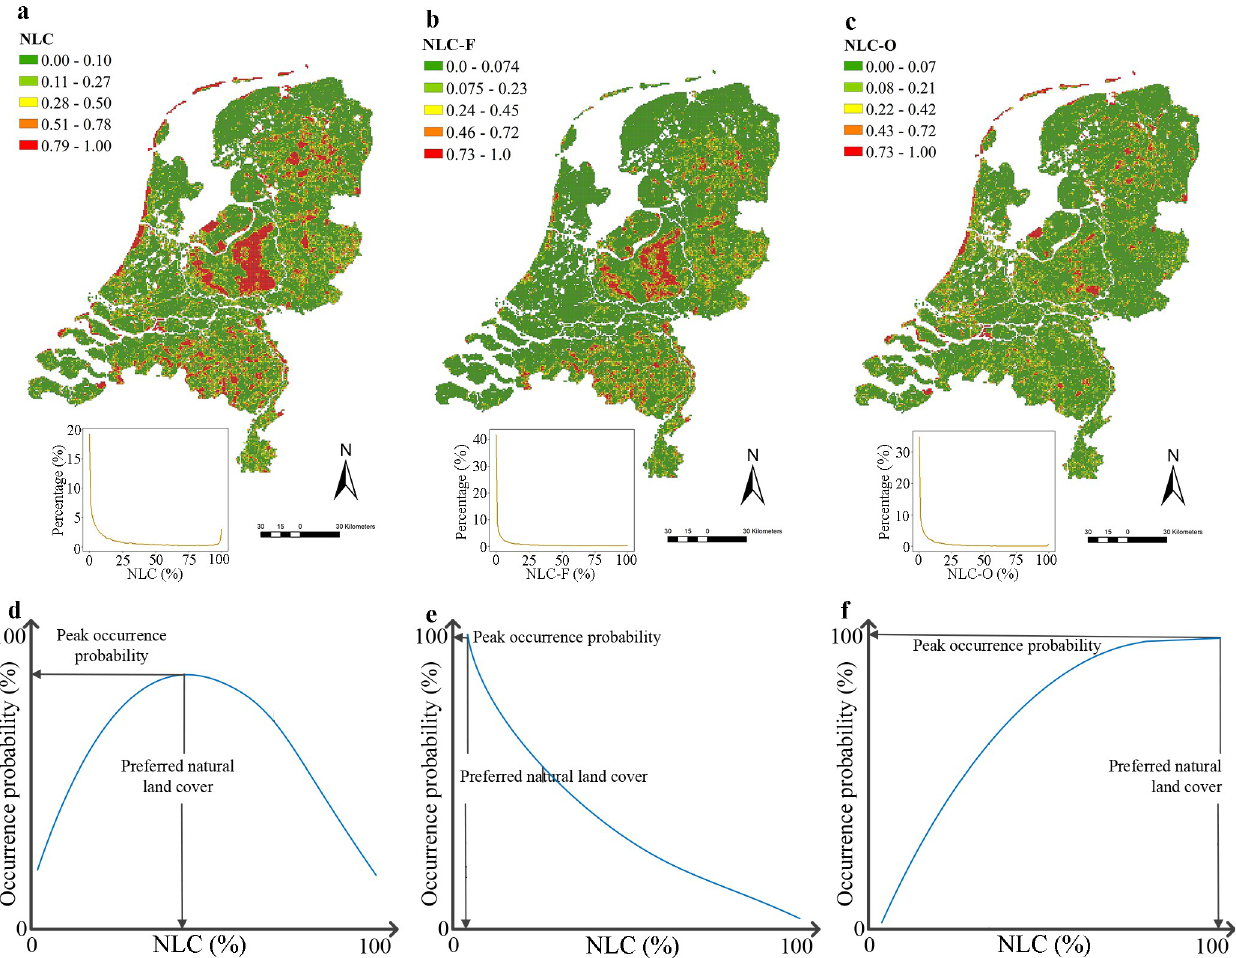
Fig 1. Land cover map and illustration of plant species responding to NLC. a, the distribution of NLC across the Netherlands. b, the distribution of the NLC-F across the Netherlands. c, the distribution of the NLC-O across the Netherlands. d-f, Illustration of three types of hypothetical curves indicating plant species responding to NLC (or NLC-F or